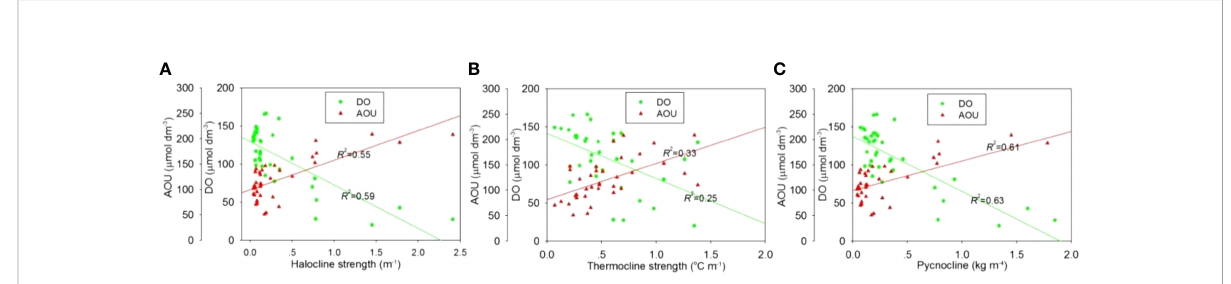
FIGURE 9 Bottom DO and AOU vs. strength of (A) halocline, (B) thermocline and (C) pycnocline off the CE in August